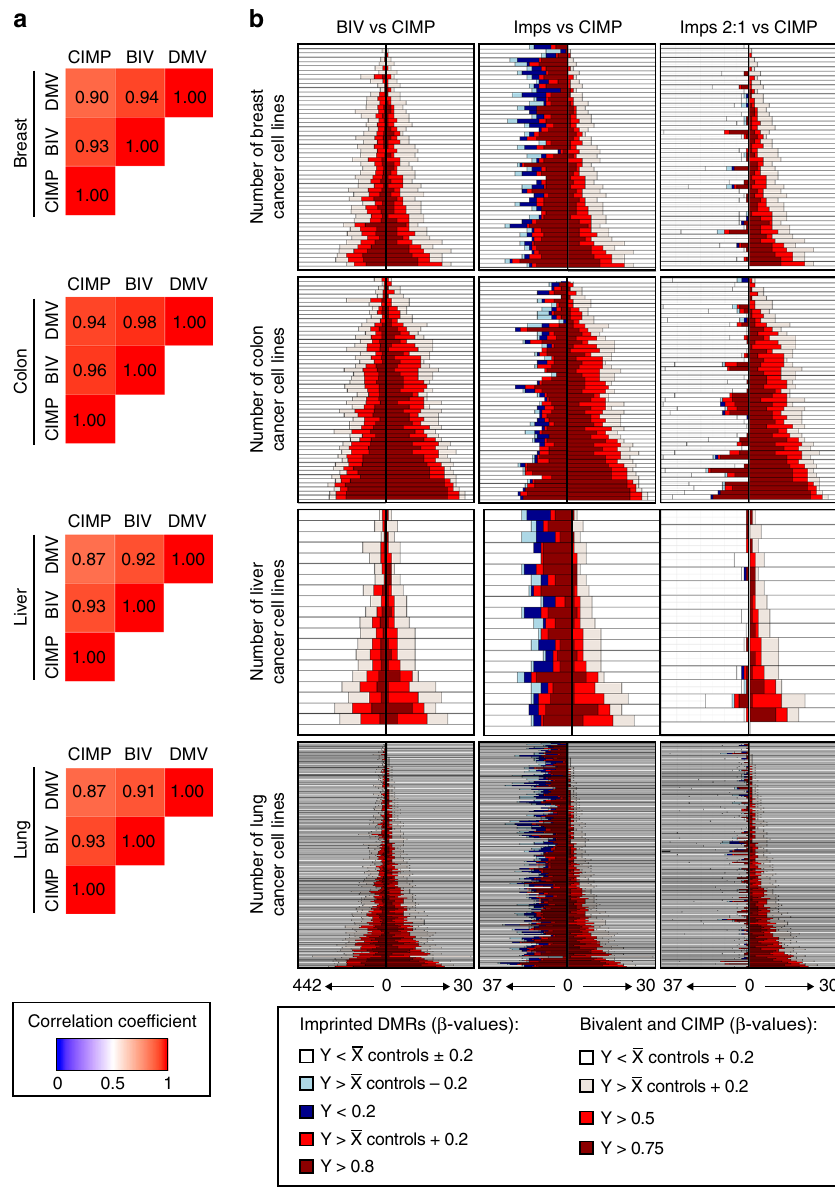
Fig. 3 The methylation pro fi les of genomic intervals susceptible to cancer-associated hypermethylation. a Heatmap of pairwise correlation coef fi cient of for CpG island methylator phenotype (CIMP), bivalent domains (BIV) and DNA methylation valleys (DMV) in the cell lines derived from the four different tissues. Numbers in the colored squares represent Pearson ’ s or Sparman ’ s rank according to data distribution. b Stacked histograms ranked according to the severity and number of affected loci per cell line. The graphs in the left column reveal that cell lines with the highest hypermethylation burden for CIMP regions are similarly hypermethylated at bivalent domains. The middle column is a comparison between the methylation pro fi les of imprinted DMRs irrespective of CNA status and CIMP. The right row is the same comparison but with only imprinted domains with a normal copy-number. For each type of loci the number of genes analyzed is indicated on the x